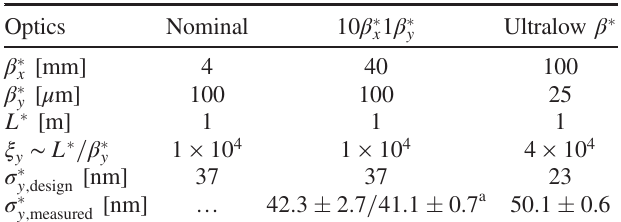
TABLE I. Key FFS parameters of ATF2 various optics. L (cid:1) is the distance between the last quadrupole and the IP, ξ y is the vertical chromaticity and σ (cid:1) y is the IP vertical beam